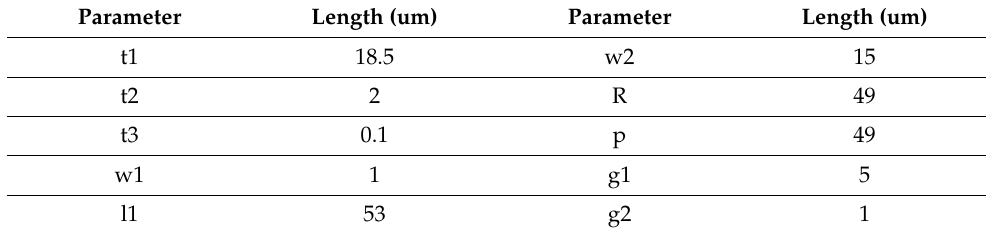
Figure 1. Structure of PCM unit. Table 1. Optimal geometric parameters of the PCM